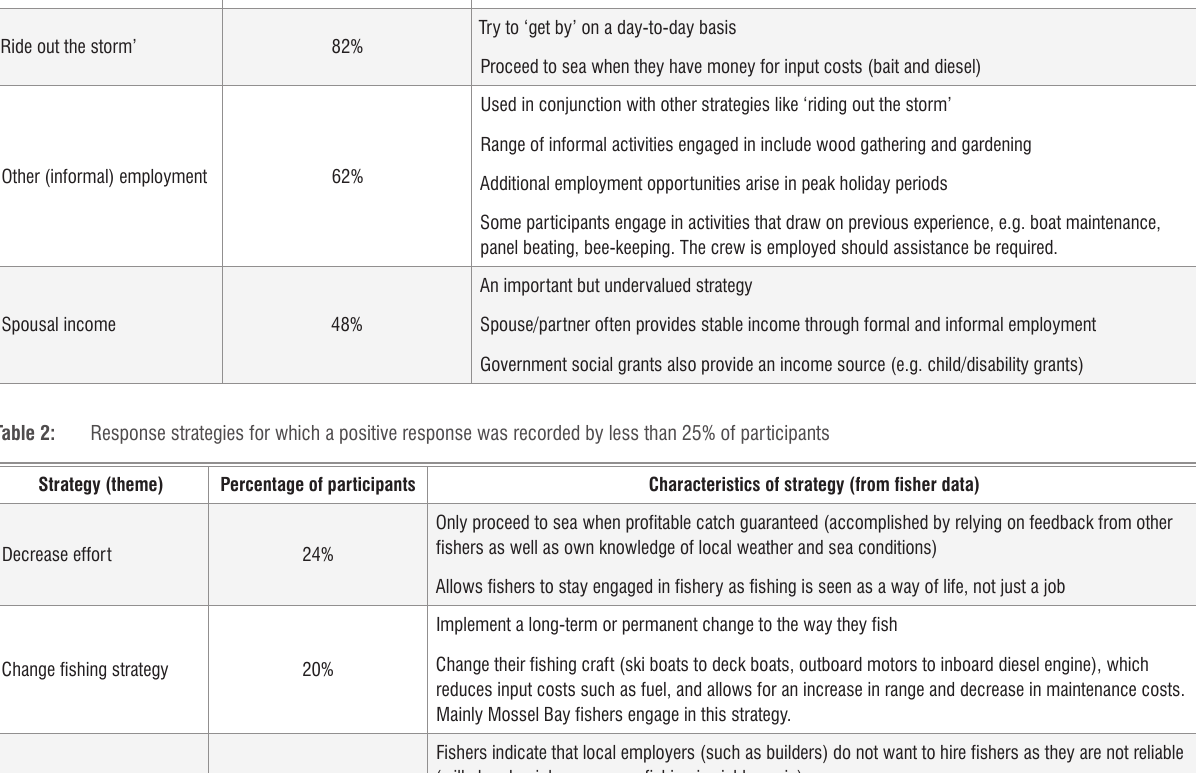
Response strategies for which a positive response was recorded by more than 40% of the participants Strategy (theme) Percentage of participants Characteristics of strategy (from fisher data)